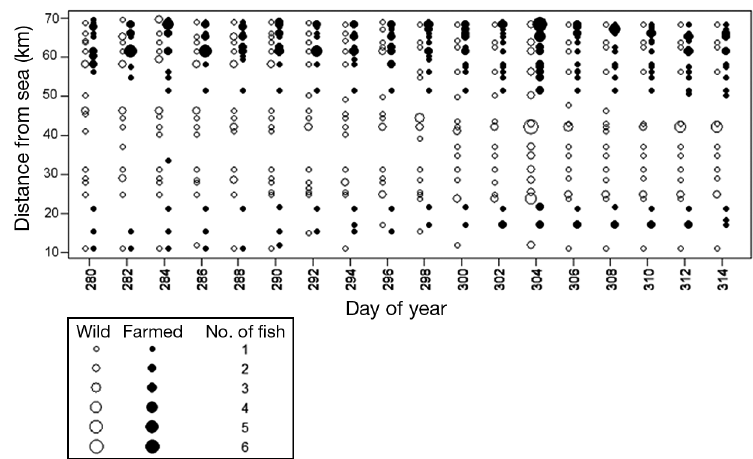
Fig. 4. Location (distance from the river mouth) of farmed and wild Atlantic salmon Salmo salar on day of the year 280 to 314 (6 October to 10 November 2012). For figure clarity, minor temporal separation of wild and farmed salmon observations have been made